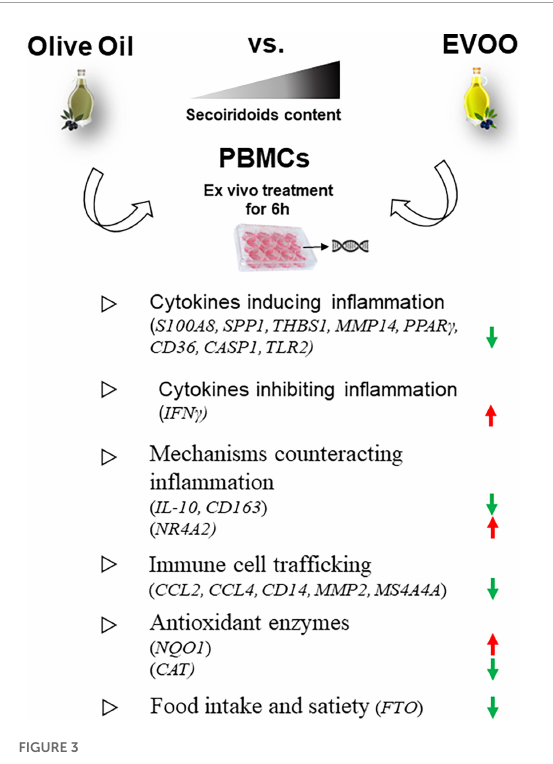
FIGURE3 Summary of the molecular modulations along with the relative pathways induced by a 6-h treatment of PBMCs with EVOO compared to olive oil extracts. Arrow direction indicates the up- or- down modulation of genes in PBMCs treated with EVOO using those treated with olive oil as reference. Green arrows: down modulated genes; red arrows: up modulated